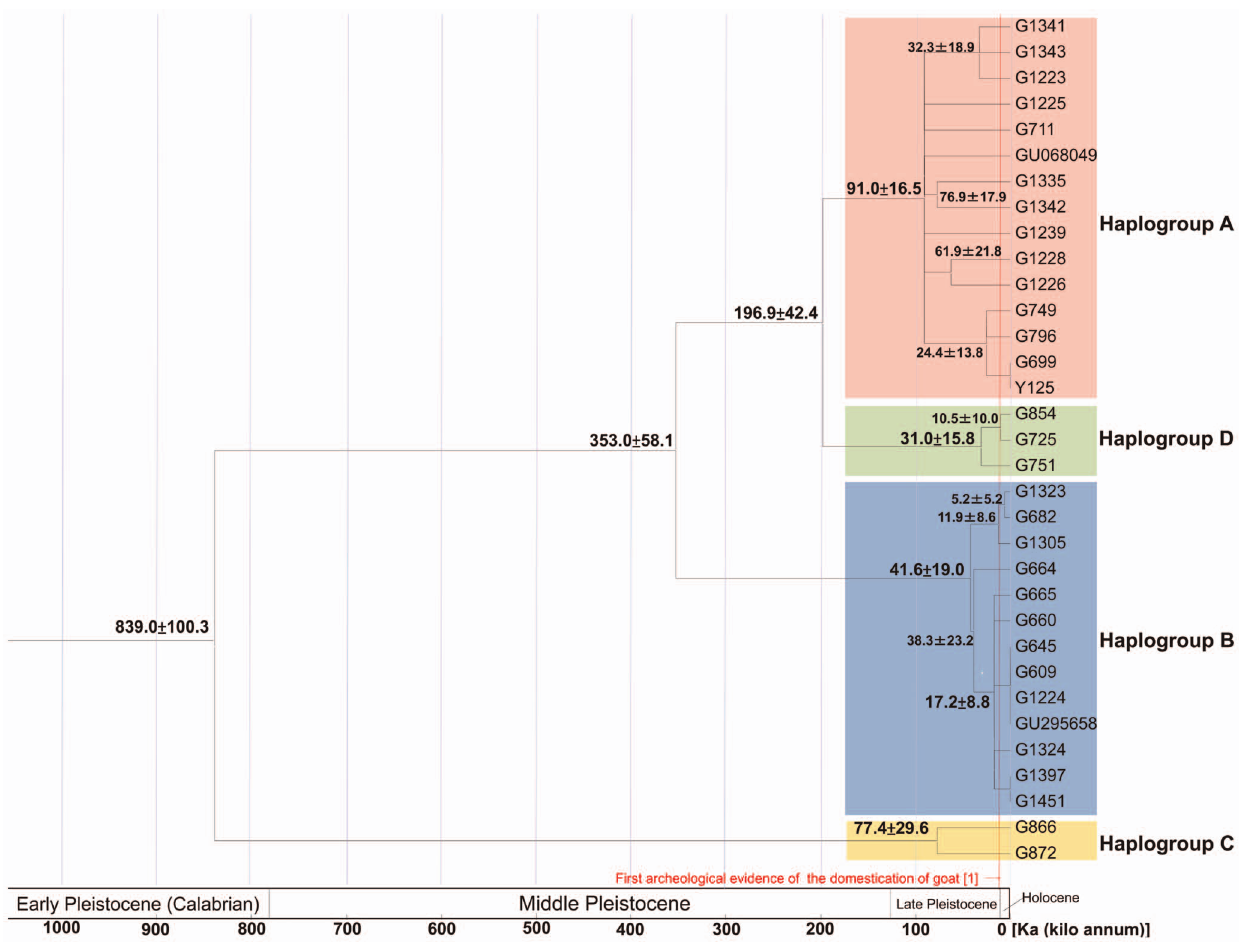
Figure 2. Coalescent time estimates for domestic goats based on 3 rd codon positions of the nearly complete mitochondrial protein- encoding genes of the smaller data set. The strict molecular clock method was applied (LRT: p-value=0.233). Branch lengths are proportional to the estimated times. Nodal numbers indicate estimated divergence times with 6 standard errors in Ka (kilo annum). Only the estimates of representative nodes are shown. The markhor was used as an outgroup and the goat/markhor split was assumed to be 3400 Ka (see main text).